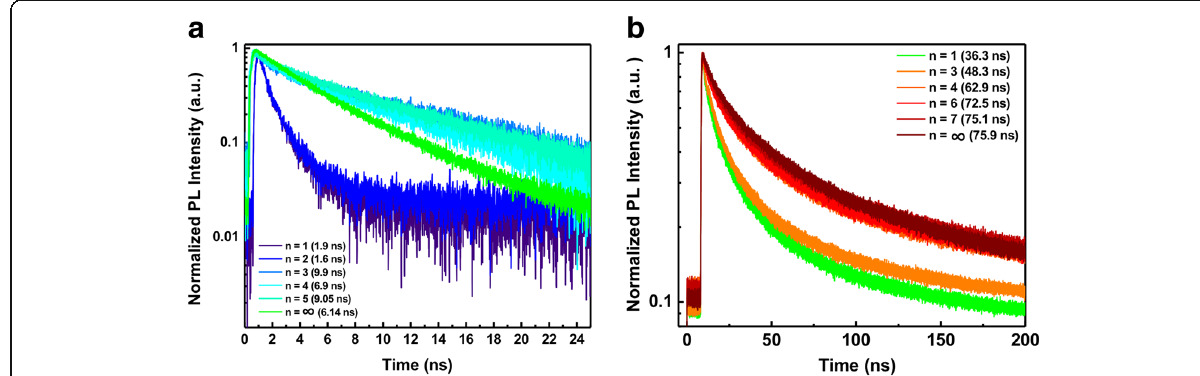
Fig. 5 Time-resolved PL decay of 2D RP perovskite QDs with a Br series and b I series by using pulse laser with a wavelength of 375 nm and 466 nm,